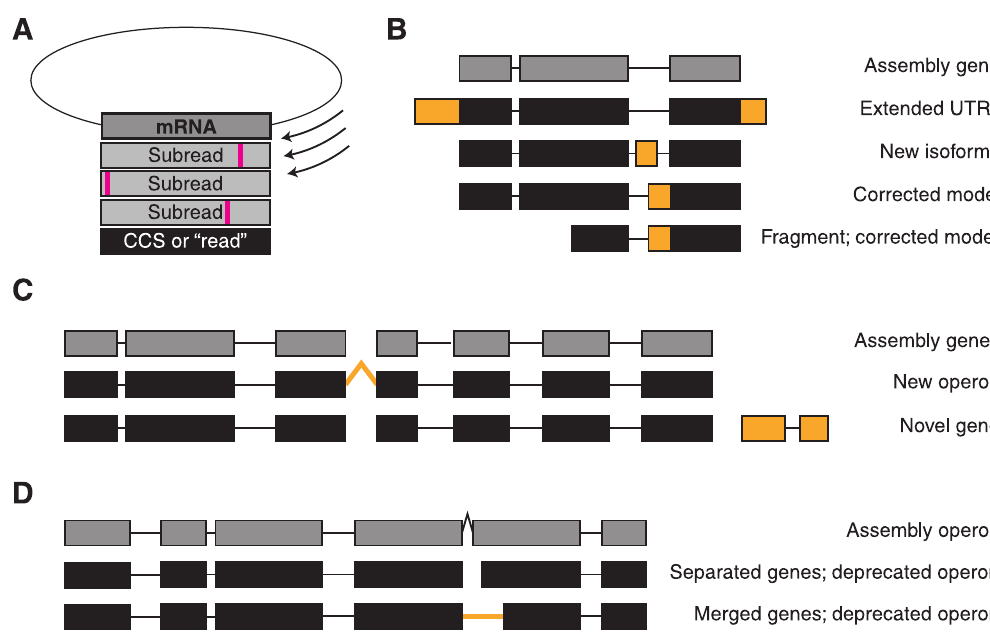
Fig 1. Improvements in gene prediction and annotation by Iso-Seq. (A) Iso-Seq libraries are prepared by isolating and ligating mRNA into a circular backbone. The polymerase can circle the template multiple times, creating multiple “subreads” per a given template. Subreads are often error-prone, but errors are corrected by alignment and consensus calling, resulting in a circular consensus sequence (CCS, termed “read” here). (B) Reads aligning to individual genes can validate the reference model and extend UTRs, identify new isoforms by discovering novel splice sites and exons, or correct the assembly model. Notably, models can be corrected even by reads arising from fragmented mRNA with 5’ degradation. (C) Reads aligning to multiple genes can indicate a new operon, and reads mapping to intergenic sequences can identify novel genes. (D) Reads aligning to an assembly operon may direct the deprecation of the operon by separating the genes or by merging the genes into a single